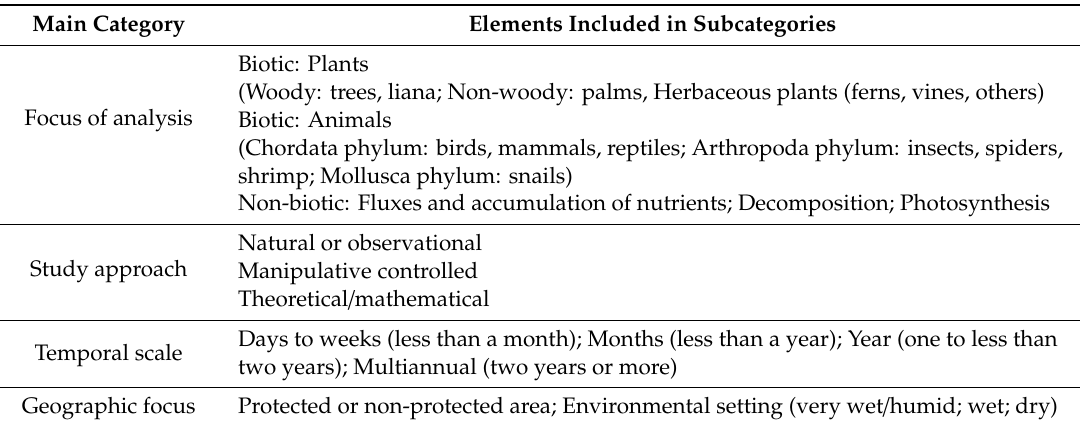
Table 2. Summary of data